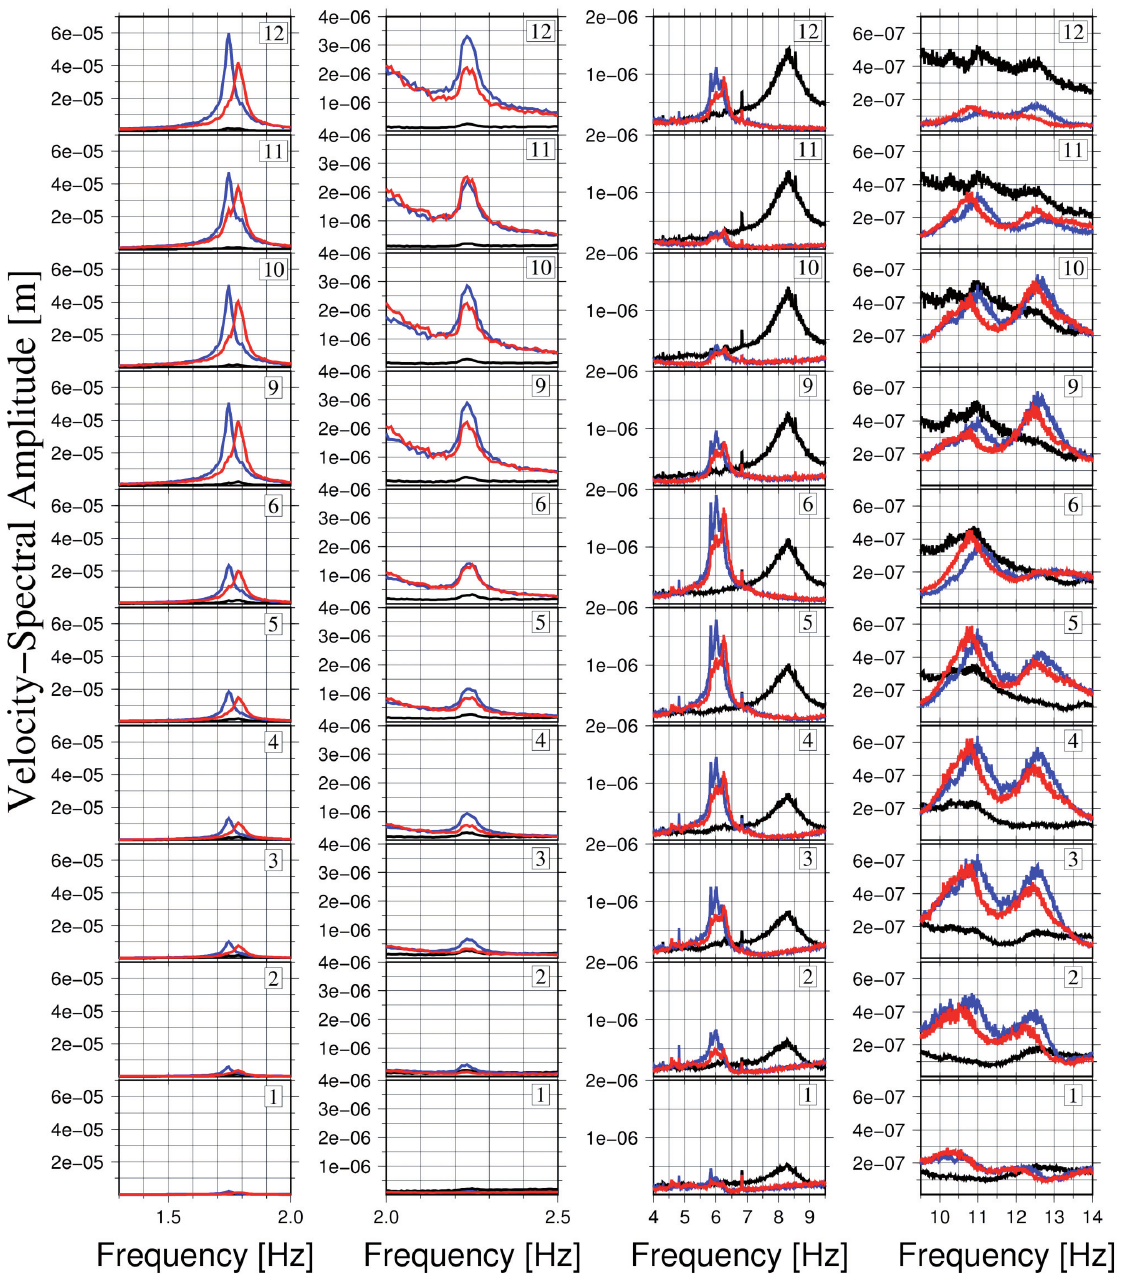
Figure 12. Average spectra computed for the sensors installed inside the 12 story monolitic RC building at position A for four different fre- quency ranges. The spectra are plotted from the 1st floor (lowermost panel) to the 12th floor (uppermost panel). The three colors (blue, red and black) correspond to the x , y and vertical components. 1st column: f = 1.3-2.0 Hz, 2nd column: f = 2.0-2.5 Hz, 3rd column: f = 4.0-9.5 Hz and 4th column: f = 9.5-14.0